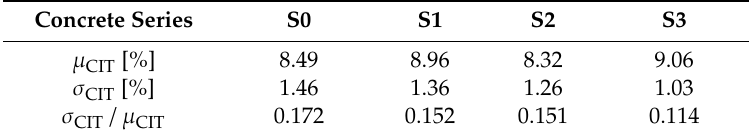
Table 6. Mean values ( μ ), standard deviations ( σ ), and the creep coefficient ( C IT ).